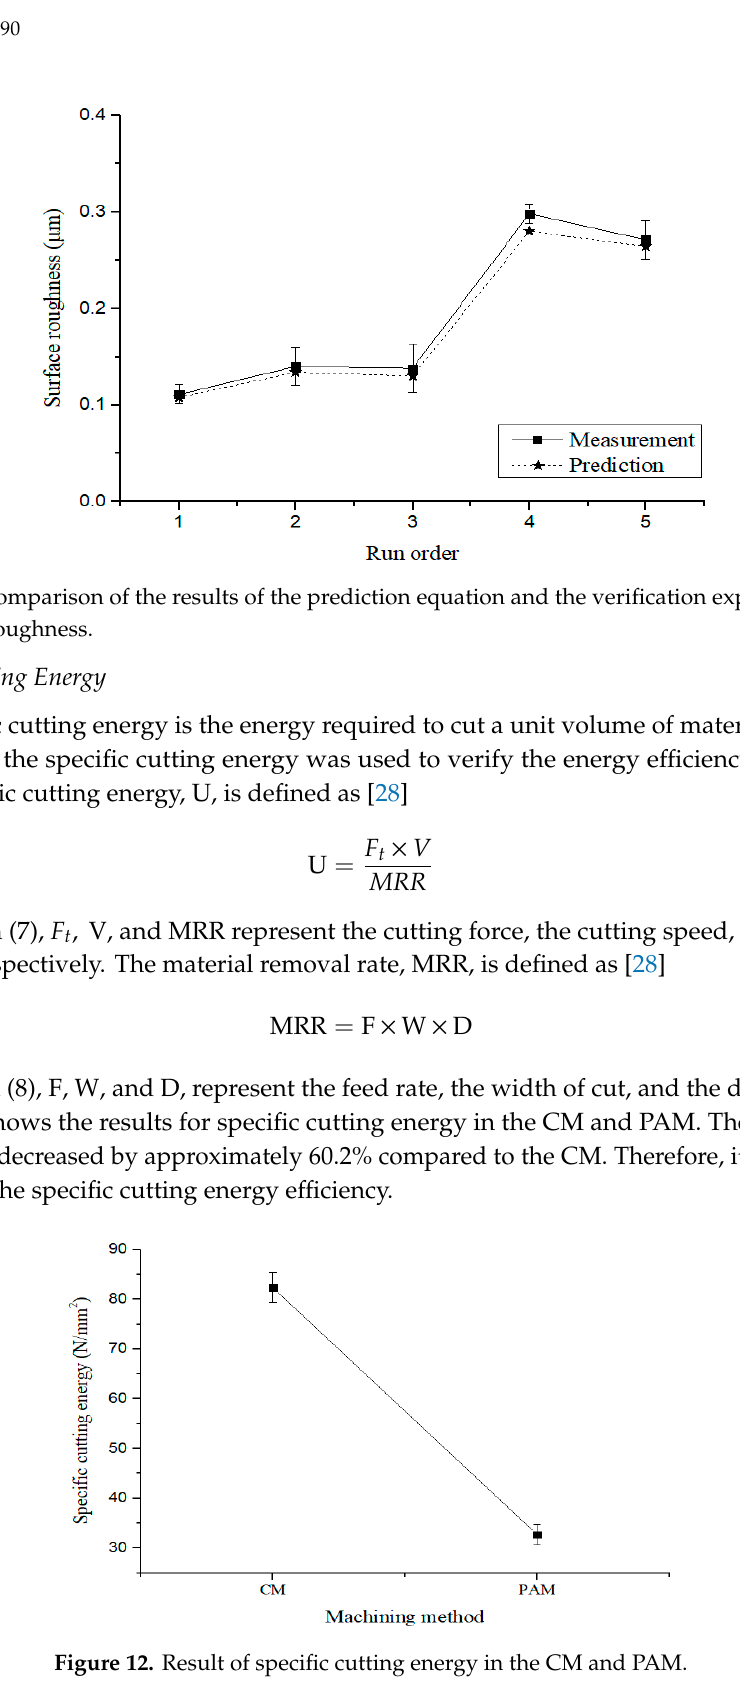
Figure 12. Result of specific cutting energy in the CM and PAM.